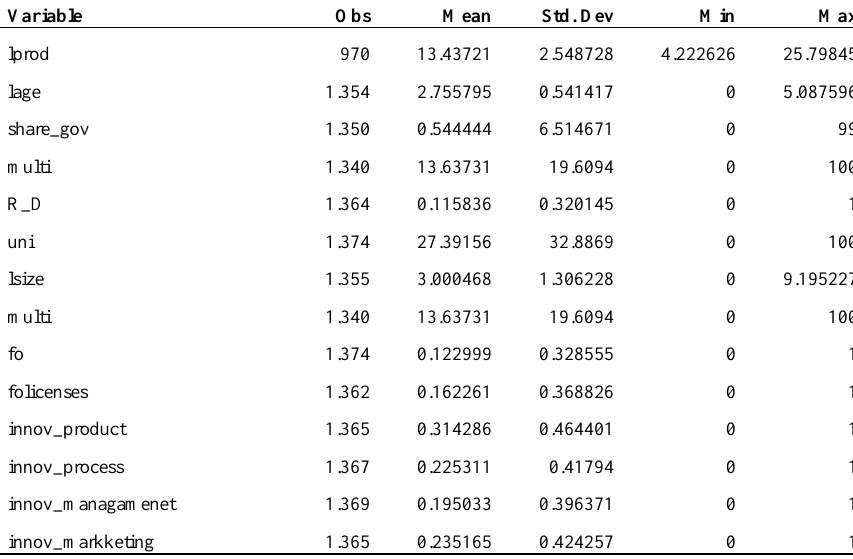
Table 2. The summary statistics for all CEE countries in the BEEPS sample